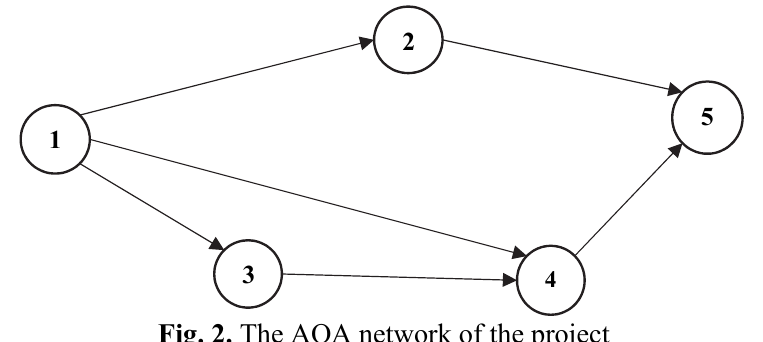
Fig. 2. The AOA network of the project